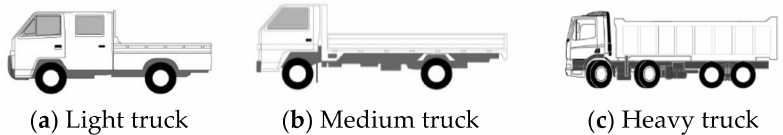
Figure 2. Illustrative schematic of truck classifications in Hong